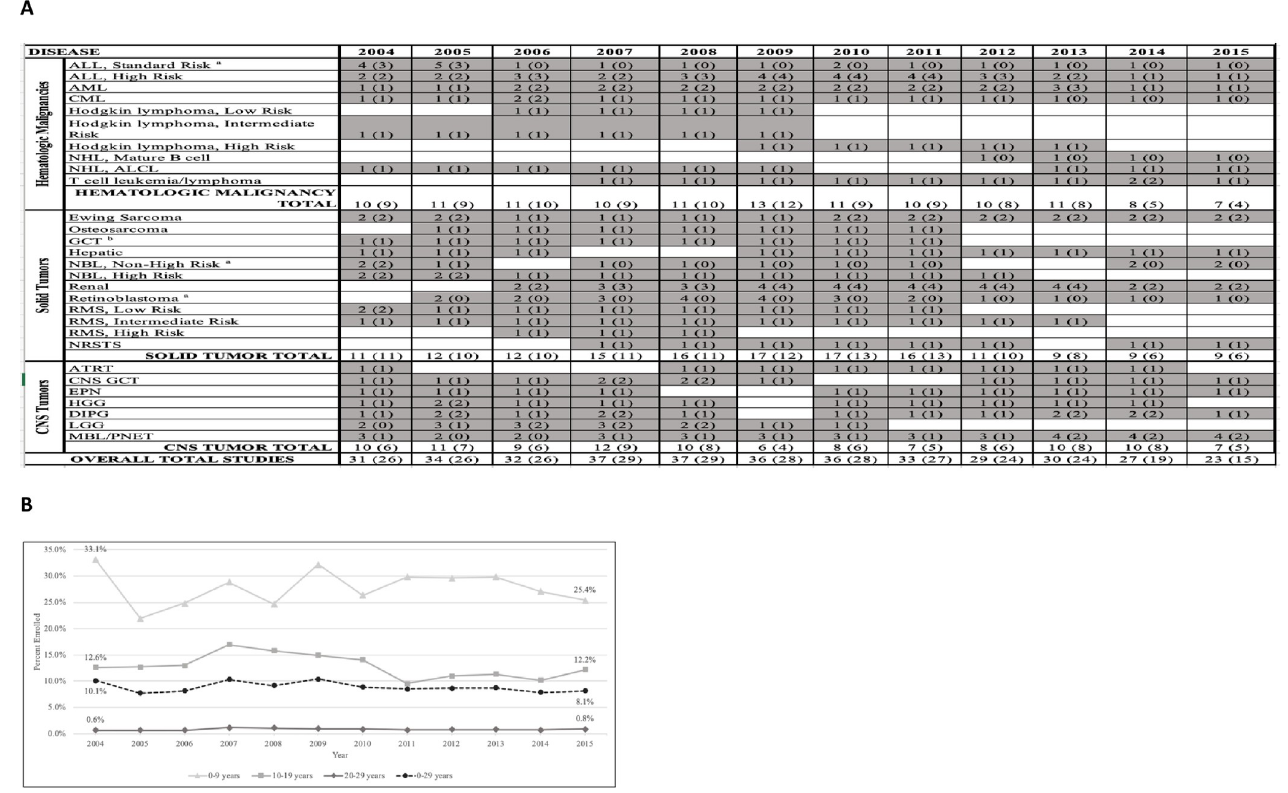
Fig 2. COG enrollment rates and available trials, 2004–2015. (A) Available Children’s Oncology Group (COG) trials for newly diagnosed patients by disease, 2004–2015 � (B) Rate of COG enrollment by age and year. � Presented data is based upon “Opened for Entry” and “Study Closed” dates on the COG member website. Columns represent number of trials open at any time during that year, overall and in which upper age eligibility � 18-years-old (in parenthesis). a Upper age limit for eligibility likely impacted by patient risk stratification definition and age population affected. b Trials for � 18-year-old patient population limited to ovarian and extragonadal tumor only, upper age eligibility for testicular tumor < 15 years old. Abbreviations: ALL, acute lymphoblastic leukemia; AML, acute myeloid leukemia; CML, chronic myeloid leukemia; NHL, non-Hodgkin lymphoma; ALCL, anaplastic large cell lymphoma; GCT, germ cell tumor; RMS, rhabdomyosarcoma; NRSTS, non-rhabdomyosarcoma soft tissue sarcoma; CNS, central nervous system; ATRT, atypical teratoid rhabdoid tumor; EPN, ependymoma; HGG, high grade glioma; DIPG, diffuse intrinsic pontine glioma; LGG, low grade glioma; MBL, medulloblastoma; PNET, primitive neuroectodermal